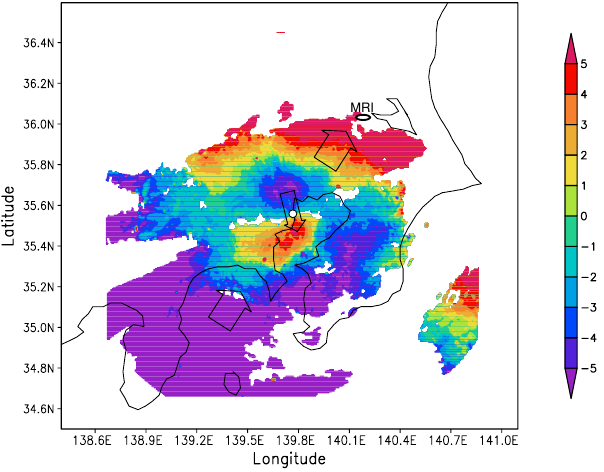
Fig. 6. Radial velocity imagery of the Haneda Doppler radar at 0.7 ◦ elevation angle over the Kanto Plain from 02:49 JST on 30 Decem- ber 1997. An open circle in the center denotes the location of the radar. An oval near the lake to the north indicates the location of the MRI. The color scale represents radial velocity (positive away from the radar). Large arrows show the wind direction at high altitude, whereas a small arrow indicates the wind direction at low altitude.